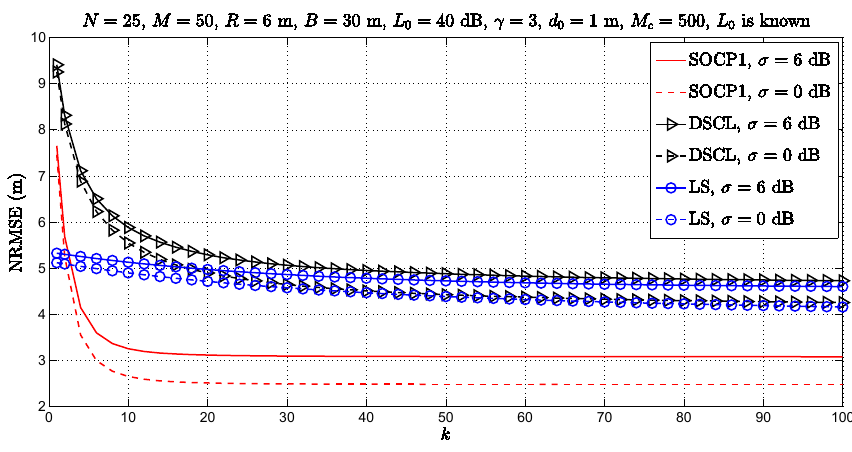
is known: NRMSE and ¯ k 0 = 40 dB, γ = 3 , 0